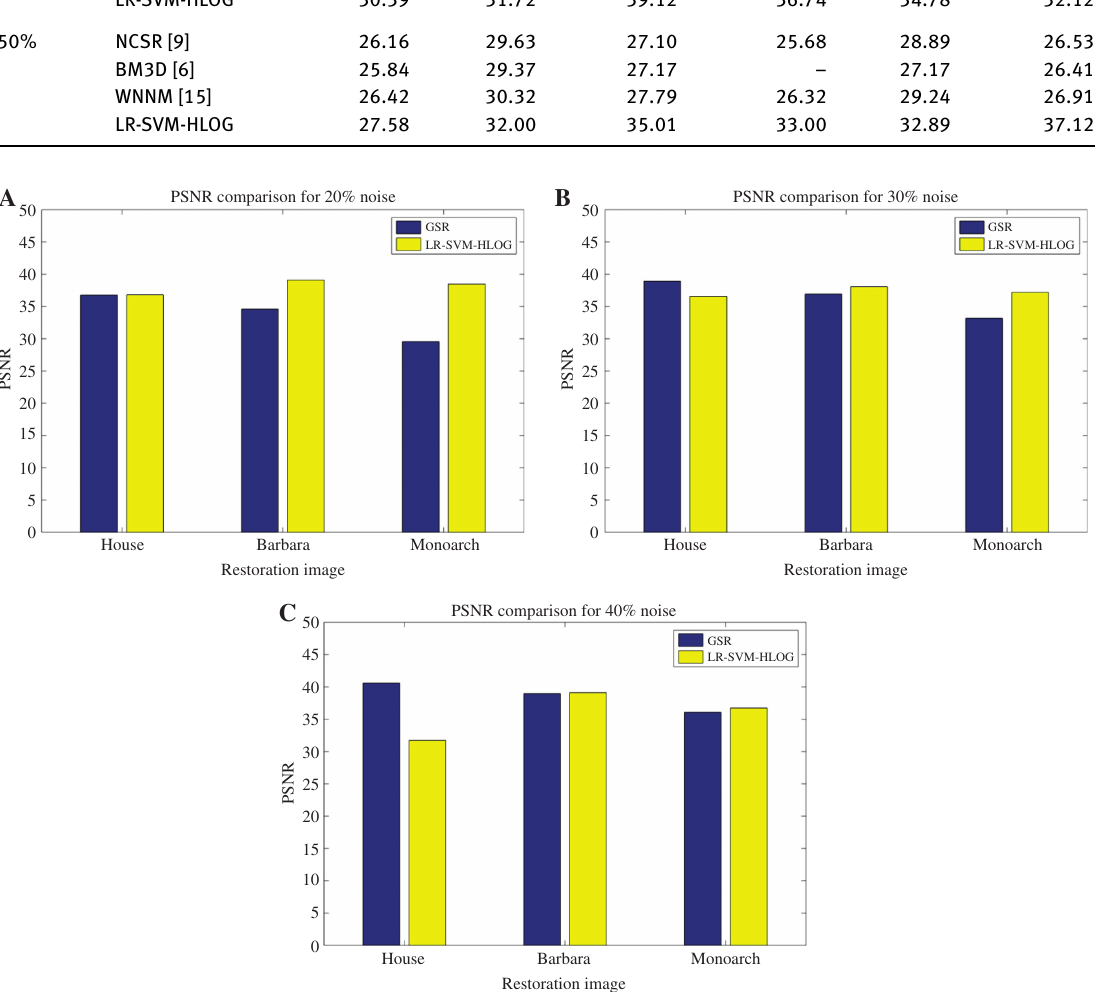
Figure 10: Comparative Analysis of Grayscale Images for LR-SVM-HLOG with GSR [44] in Different Noise Levels of 20%, 30%, and 40%. (A) Comparative analysis of gray scale images for 20% noise, (B) comparative analysis of gray scale images for 30% noise, (C) comparative analysis of gray scale images for 40%